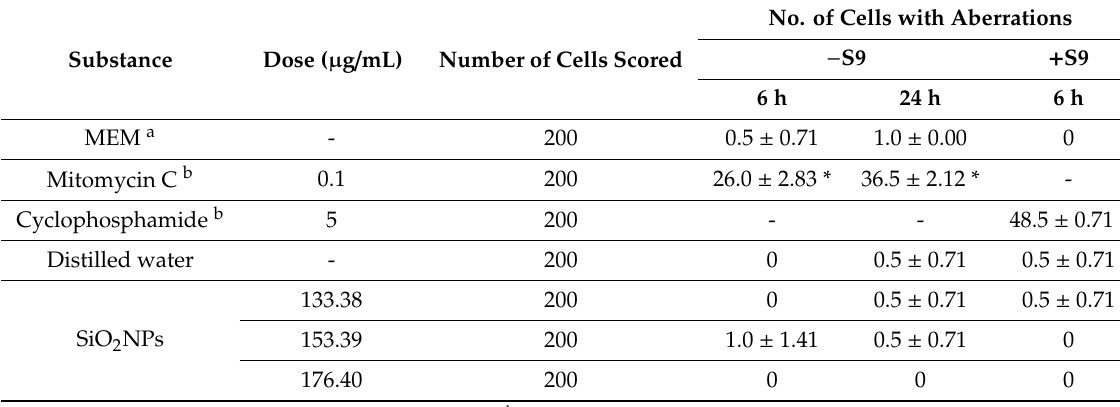
Table 3. Results of chromosomal aberration induced by SiO 2